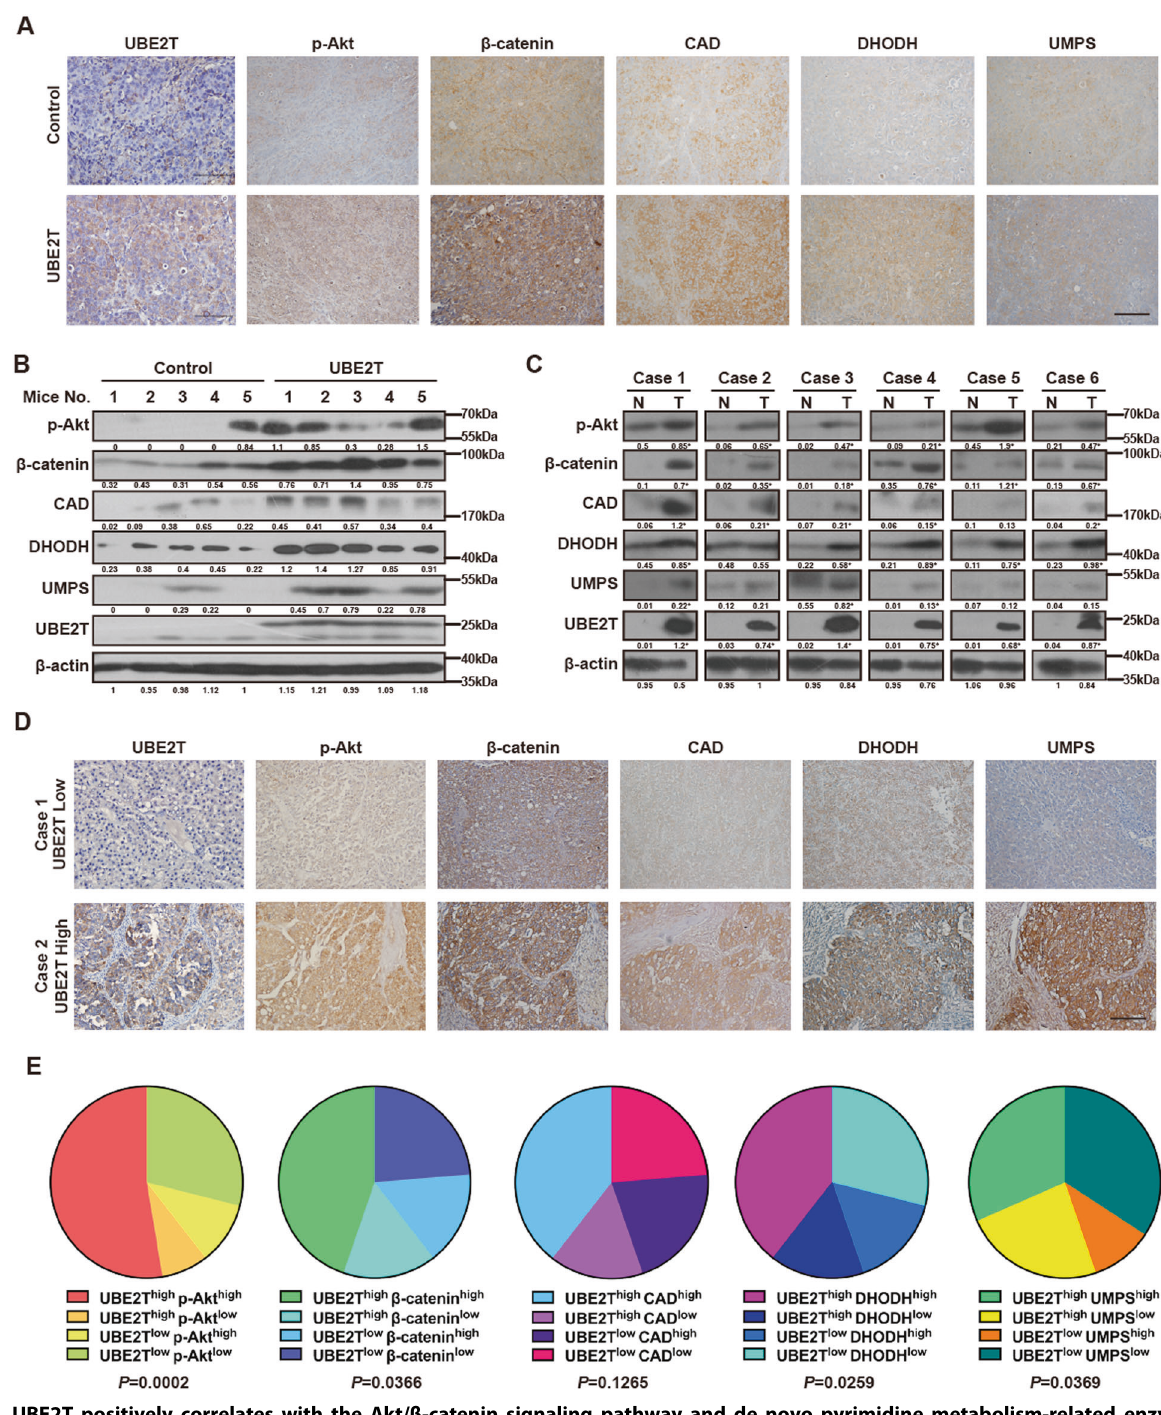
Fig. 7 UBE2T positively correlates with the Akt/ β -catenin signaling pathway and de novo pyrimidine metabolism-related enzymes in HCC. A The representative images of IHC staining for the indicated proteins in xenografts derived from UBE2T-overexpressing or control HCC- LM3 cells. Scale bar = 100 μ m. B WB was performed to detect the indicated proteins in xenografts derived from UBE2T-overexpressing or control HCC-LM3 cells. C WB of the indicated protein in six pairs of HCC tissues (T) and matched non-tumorous liver tissues (N) was performed. D Representative cases of HCC specimens with high level or low levels of UBE2T from 38 HCC patients were analyzed by IHC staining with the indicated proteins. Scale bar = 100 μ m. E The expression of the indicated proteins in 38 HCC specimens were analyzed by IHC analysis. The relative proportions of protein expressions were illustrated as a pie chart. * P < 0.05, ** P < 0.01, *** P < 0.001, **** P < 0.0001 by chi-square test. The average gray values and the statistical data were shown under the corresponding band. Student ’ s t -test was used for comparisons, * P < 0.05, ** P < 0.01.